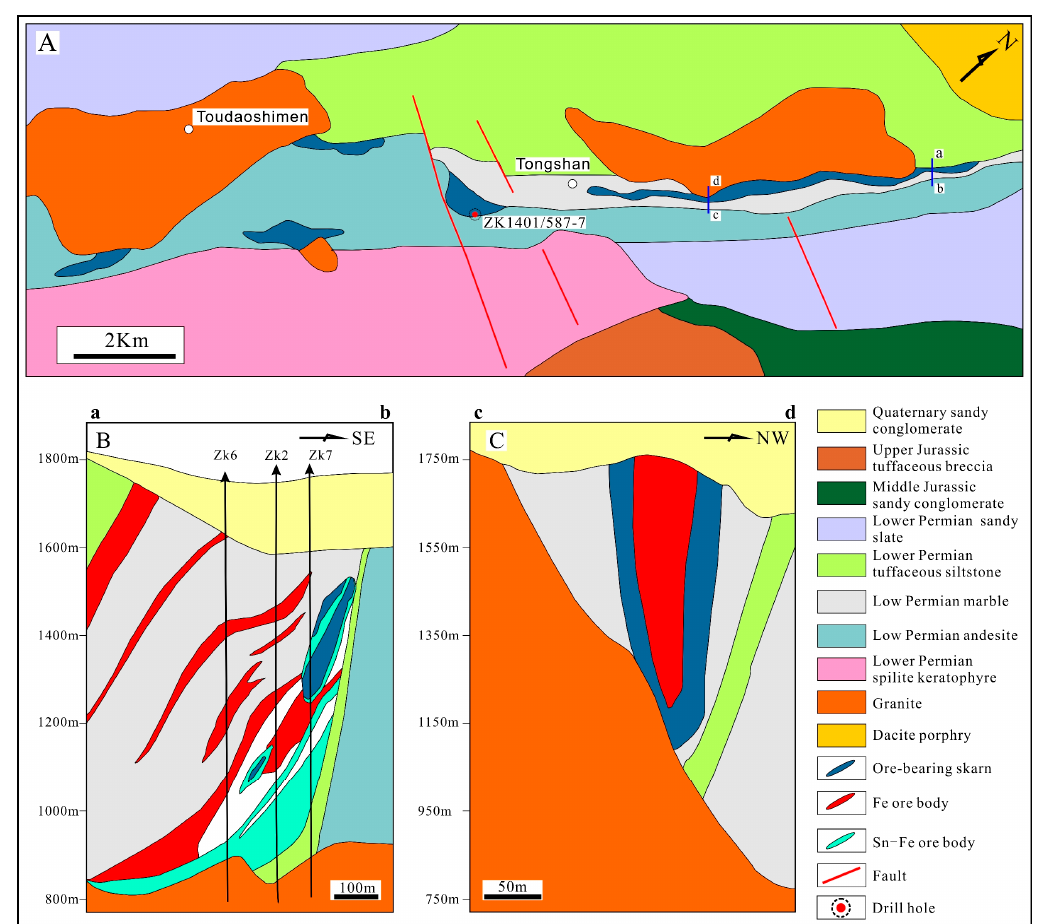
Figure 2. Simplified geological map ( A ) and cross sections ( B , C ) of the Huanggangliang Sn-Fe deposit. Modified from Reference [17].